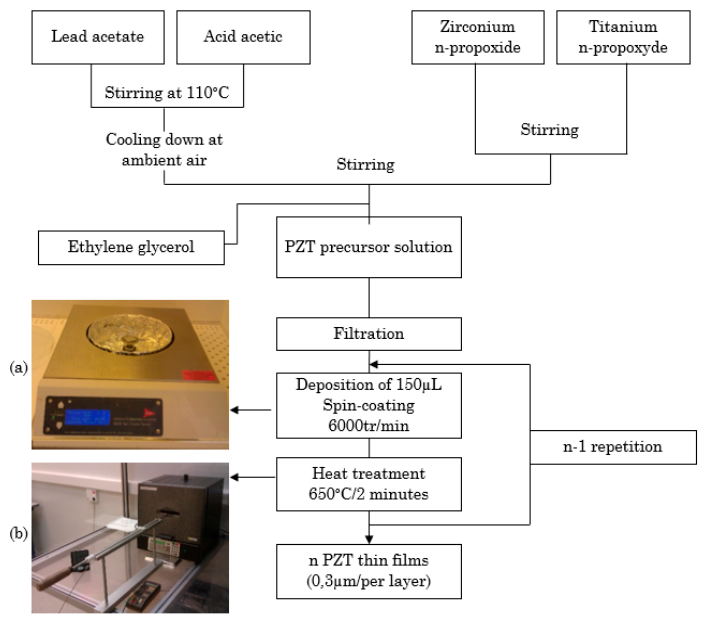
Figure 3. Deposition process of the PZT thin films ( a ) Spin coating equipment; ( b ) Oven used for the heat treatment of the thin films.